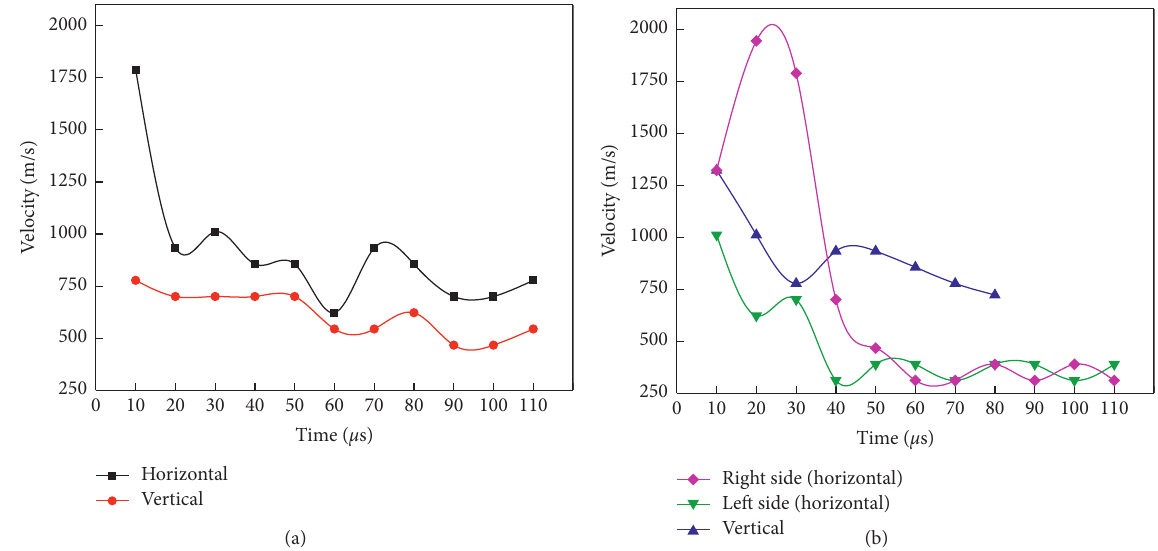
Figure 6: Shock wave front velocity in (a) parallel and (b) perpendicular orientations of the charge.